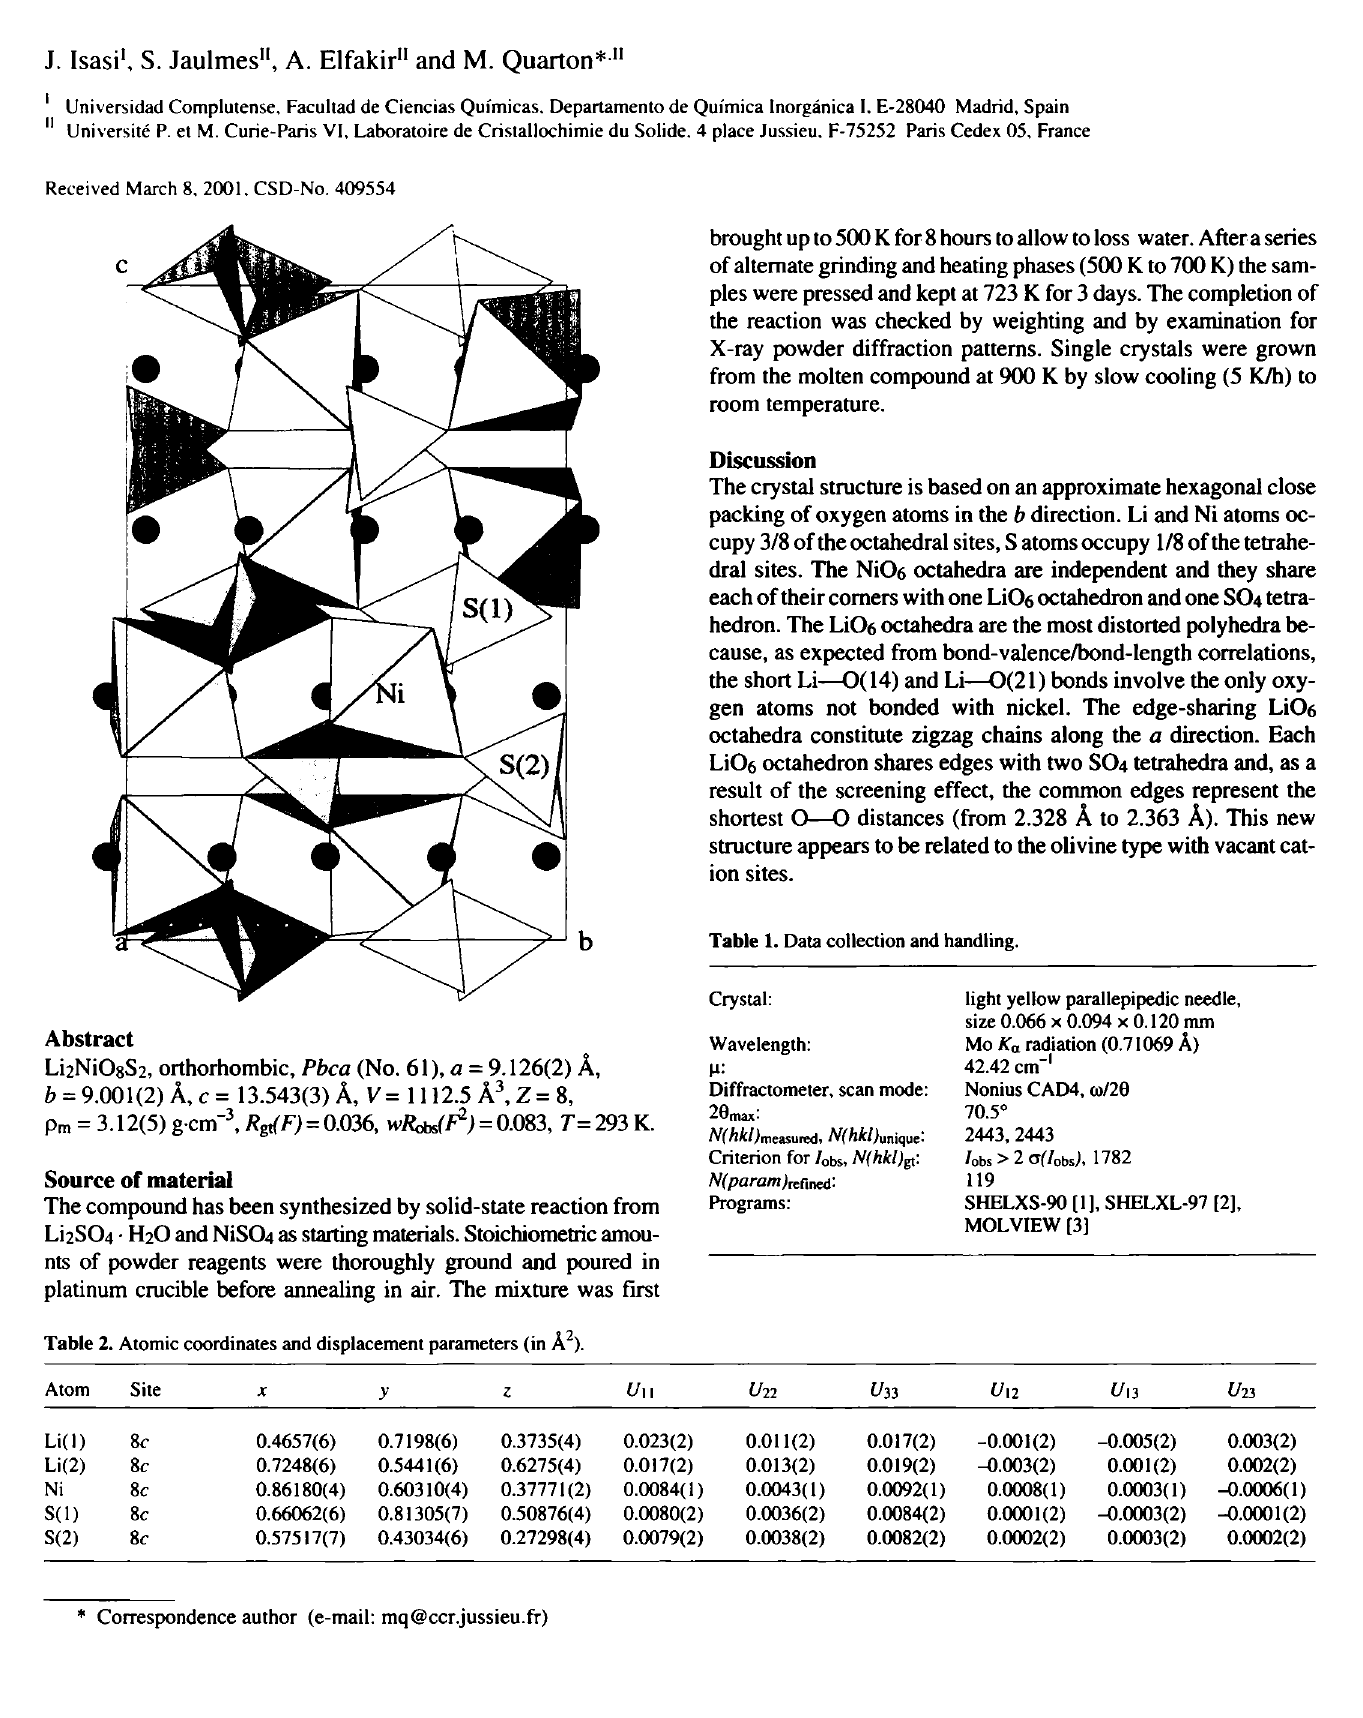
Table 2. Atomic coordinates and displacement parameters (in Ä 2